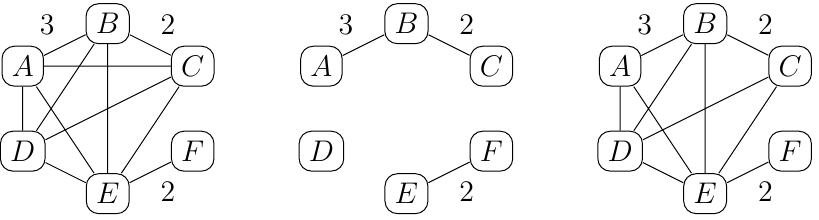
Figure 4. An execution of the algorithm AG-max-weight (the edge labels that are equal to 1 are Figure 4: An execution of Algorithm AG-max-weight (the edge labels that are equal to 1 are omitted).